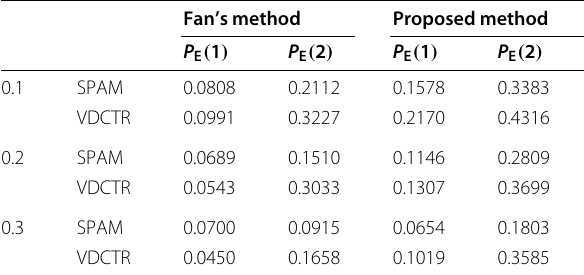
Table 6 The error rate P E at the embedding rate of 0.1, 0.2 or 0.3